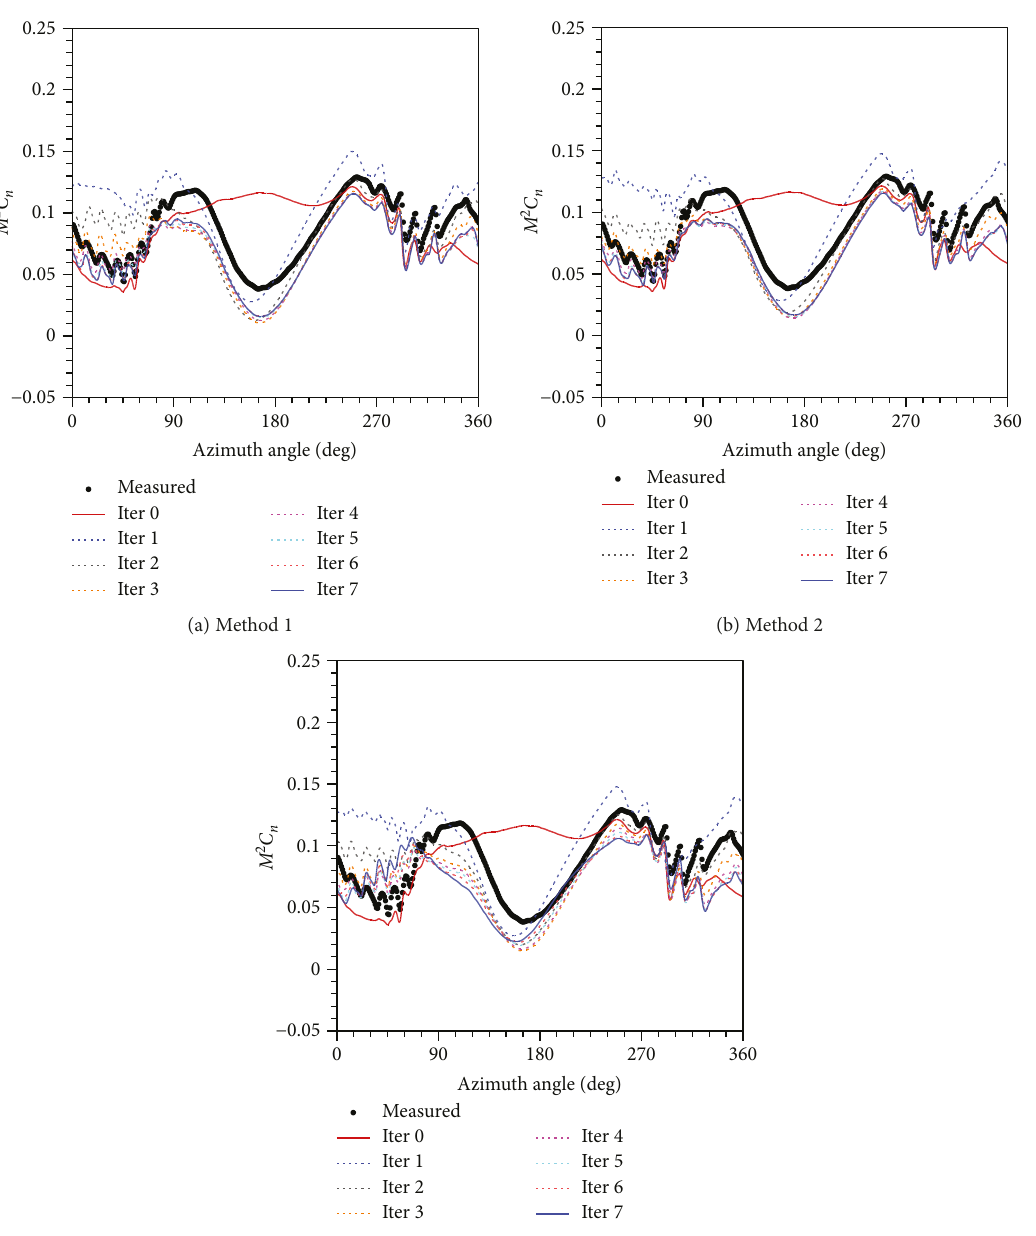
at r / R =0.87 with coupling n